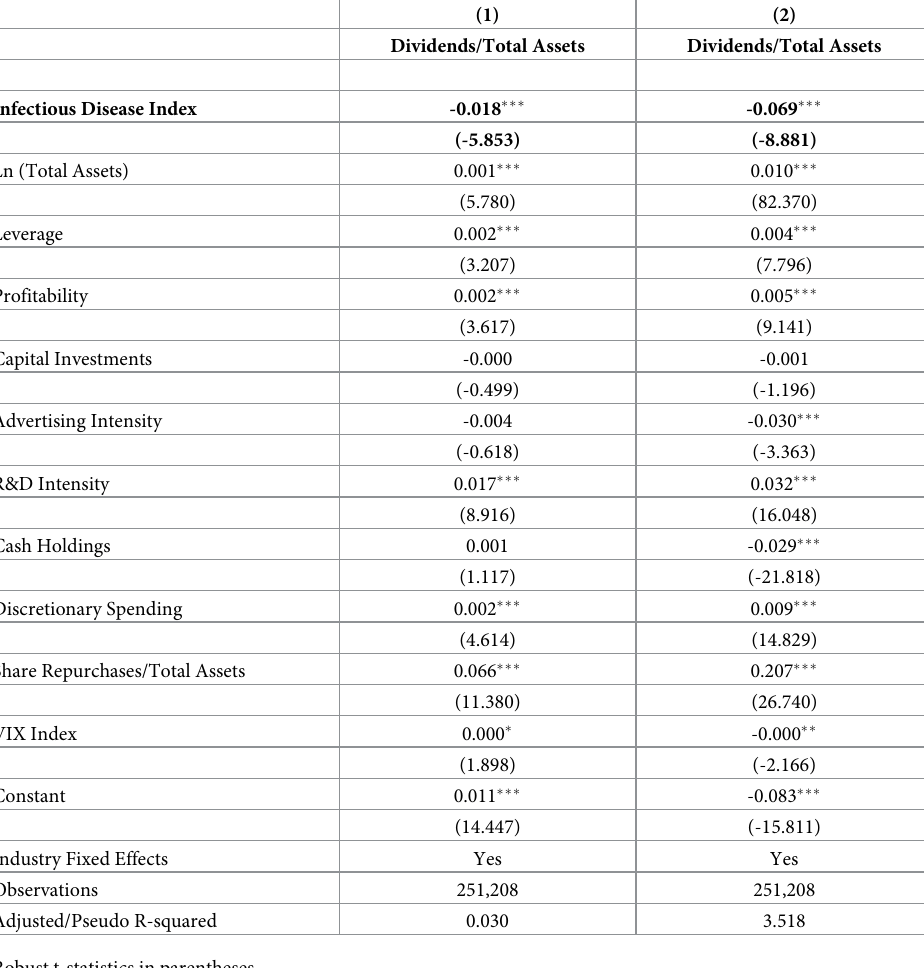
Table 3. Regression analysis controlling for VIX (CBOE volatility index). Our measure of disease-related uncer- tainty is the infectious disease equity market volatility developed by Baker et al. (2020) [9]. Using sophisticated textual analysis, Baker et al. (2020) [9] search for news articles related to infectious diseases and equity market volatility. A higher fraction of these news articles to all articles in each time period signifies a higher level of market uncertainty that can be ascribed to infectious diseases. For ease of interpretation, we have the infectious disease equity market volatility index divided by